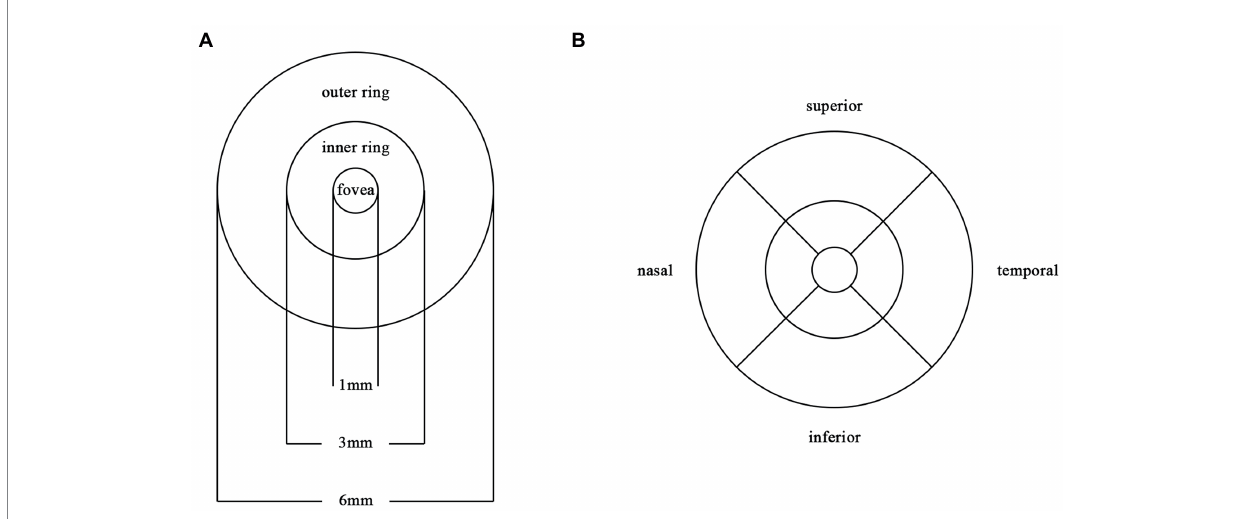
FIGURE 1 Partition diagram Partition diagram of the macula. (A) The macula is divided into 1×1mm fovea, 3×3mm inner ring and 6×6mm outer ring. (B) The inner ring and outer ring are divided into superior, inferior, nasal and temporal subregions.